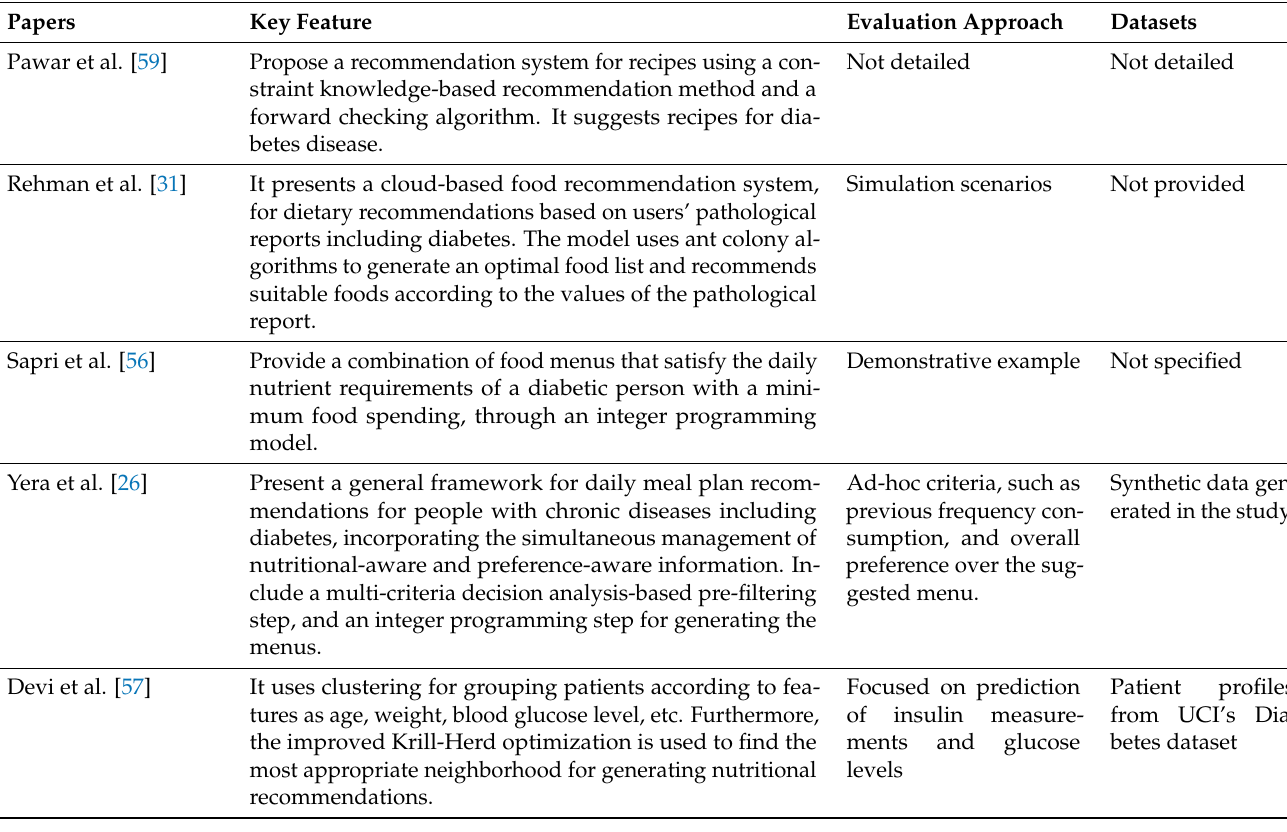
Table 2. Summary of the identified related works using optimization